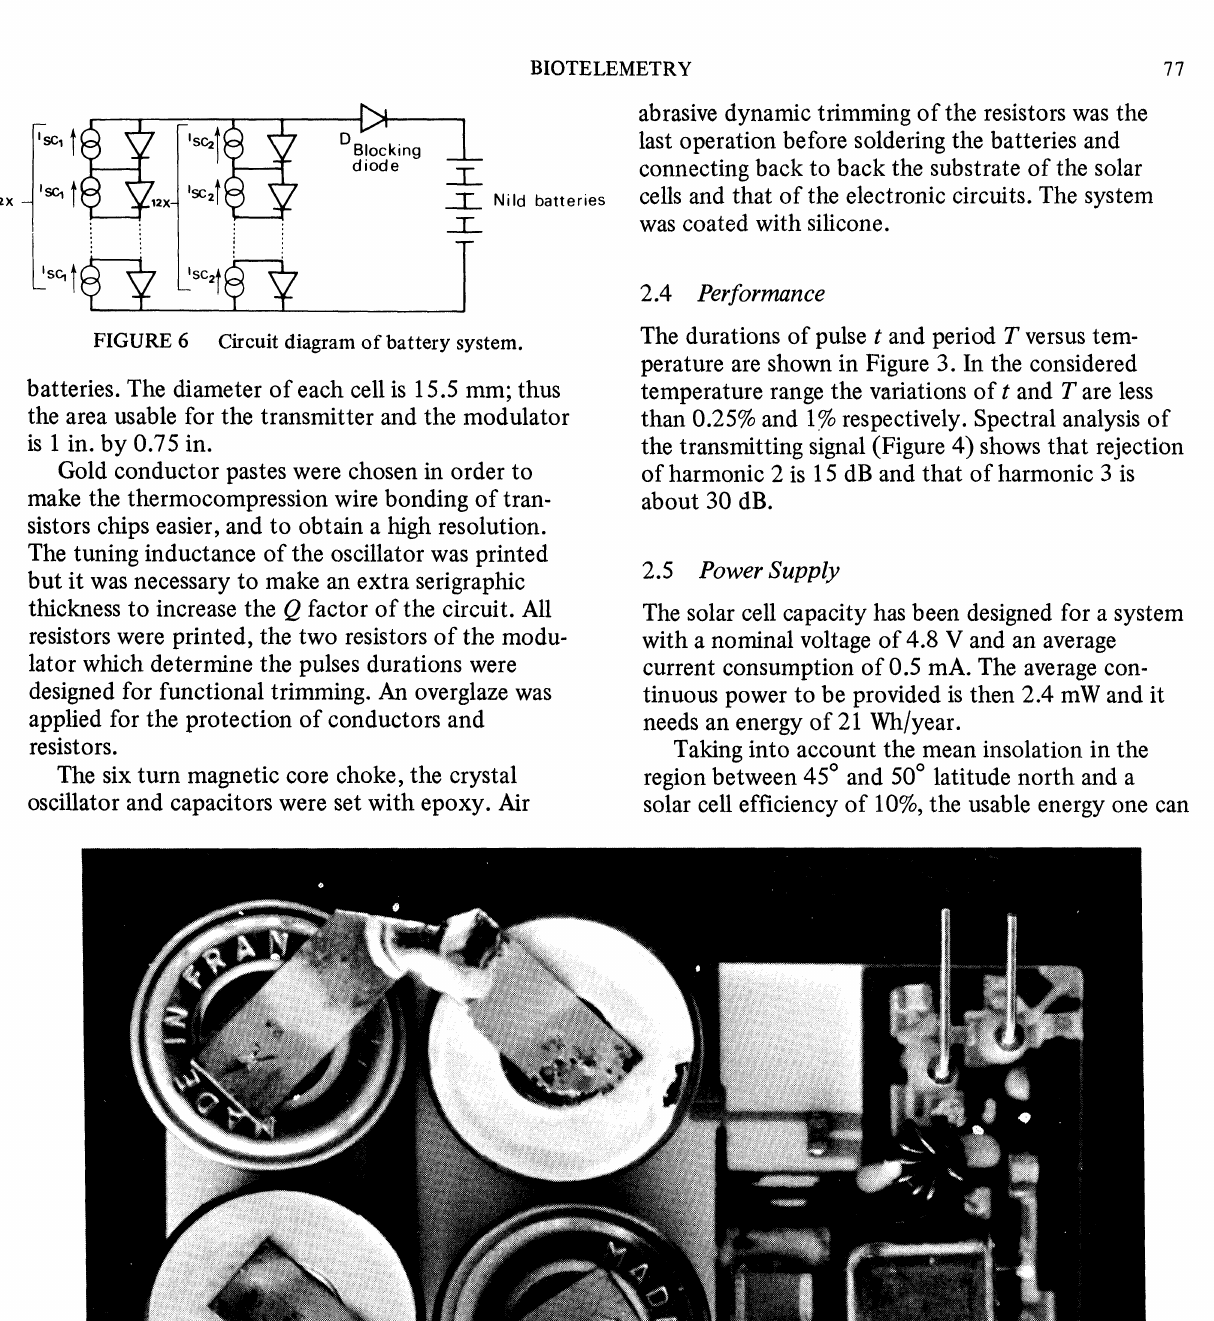
FIGURE 7 View of complete